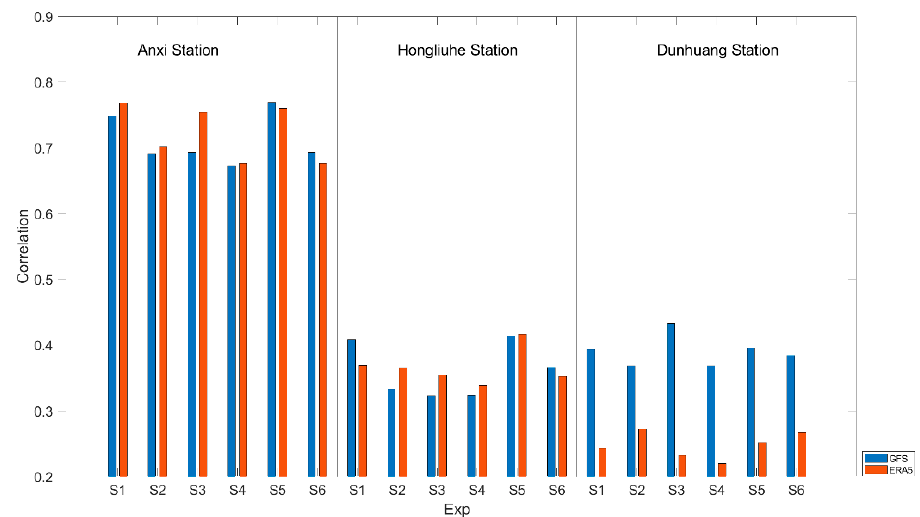
Figure 2. Correlation coe ffi cients between 10-m simulated wind speed (WS) and observed WS with the combinations of di ff erent initial data and di ff erent parameterization schemes. Table 3. Average correlation coe ffi cients (Rs) of di ff erent combinations of initial data and parameterization schemes. R